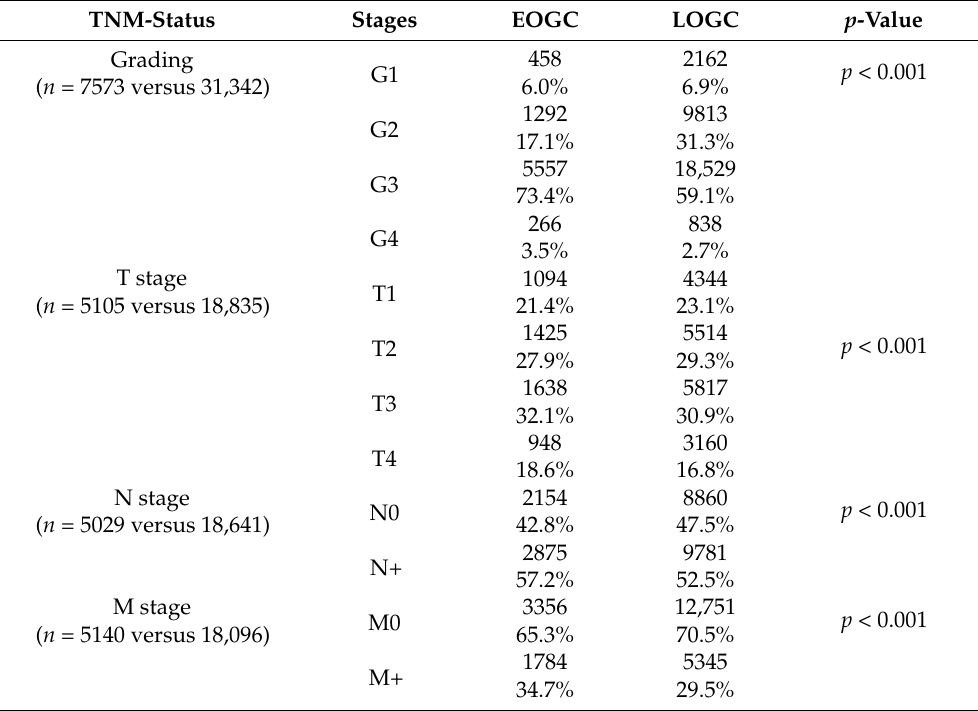
Table 1. Overview of tumor characteristics (TNM-/G-stage) in both